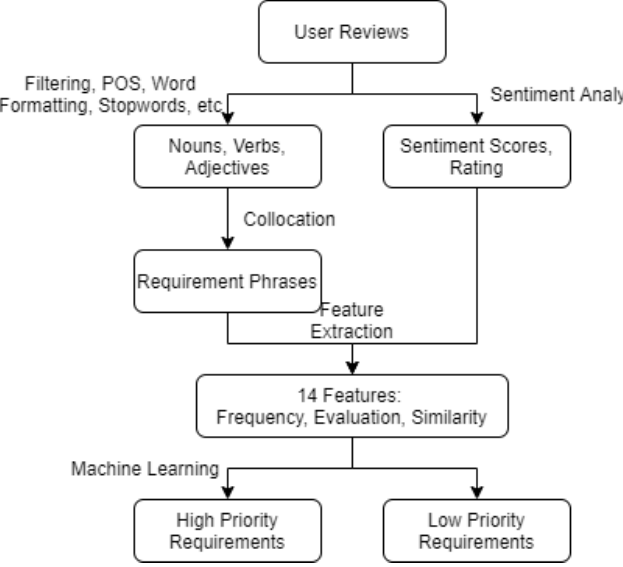
Figure 2. The overall architecture of the